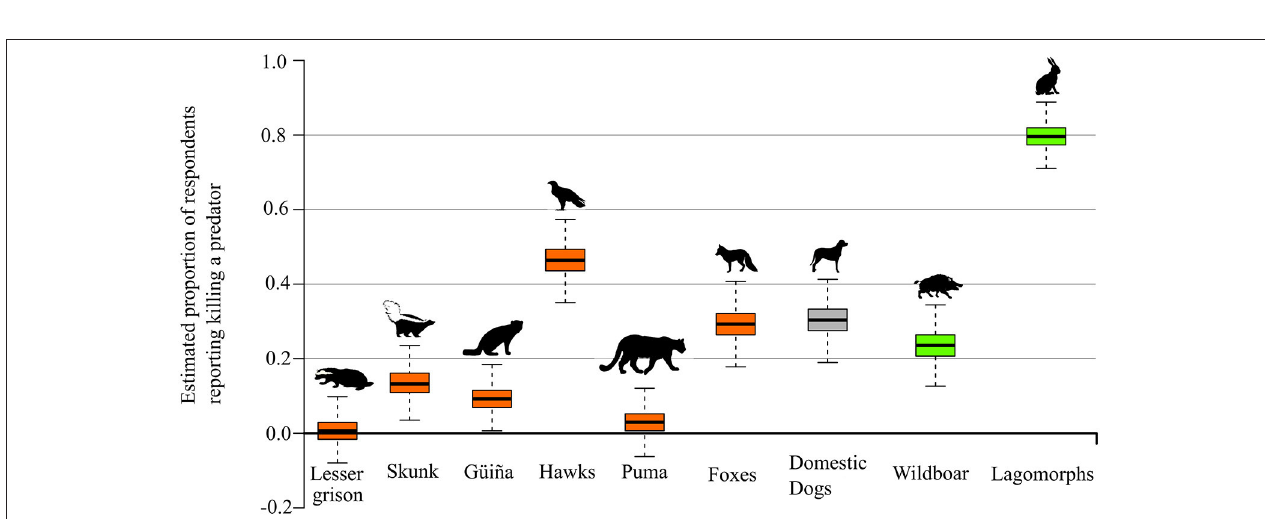
FIGURE 4 | The proportion of questionnaire respondents ( N = 233) admitting to killing a species in the past decade. Values were estimated by the randomized response technique (RRT) and 95% confidence intervals were obtained from 10,000 bootstrapped samples. The species are grouped according to whether or not hunting is permitted under Chilean hunting law or not (illegal to hunt native species, orange; legal to hunt introduced species, green). Domestic dogs (gray) are not listed as either legal or illegal to hunt in the